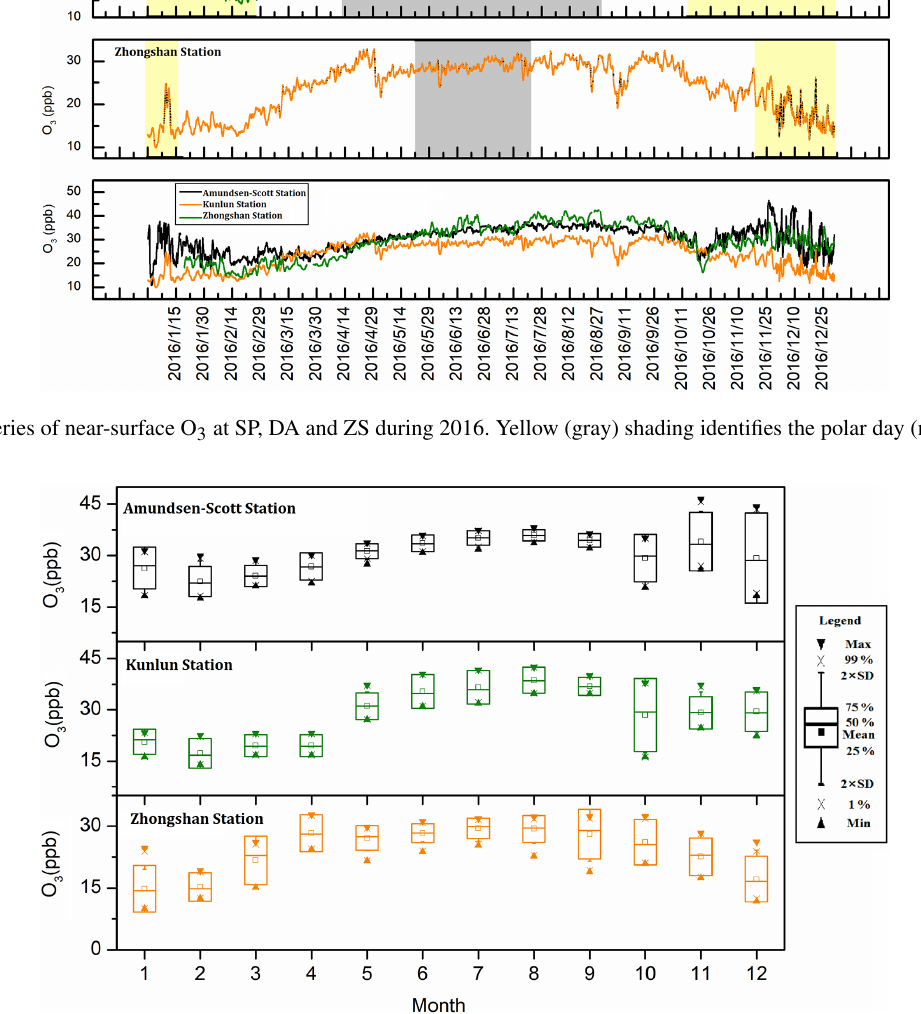
Figure 3. Monthly average and statistical parameters of near-surface O 3 at SP, DA and ZS during